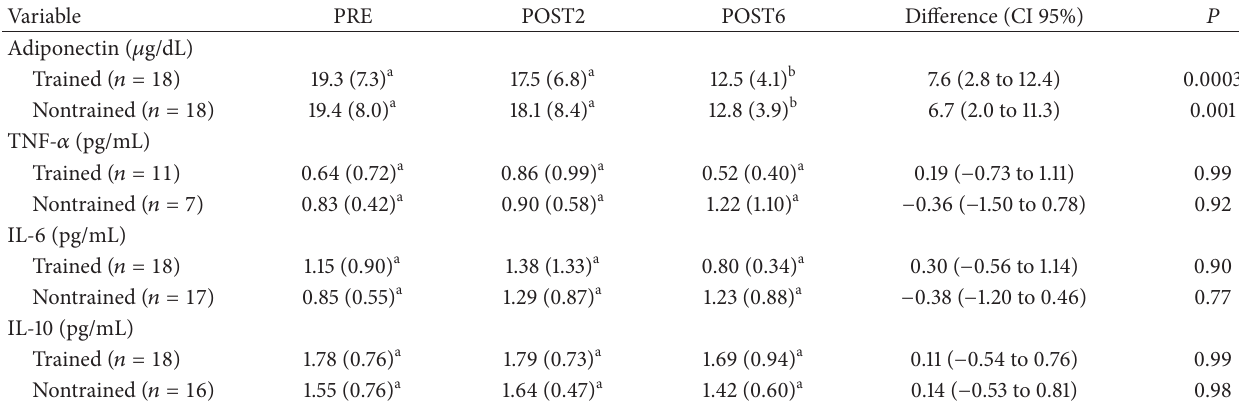
Table 1: Effects of liposuction and exercise training on adipokine levels in normal-weight women.